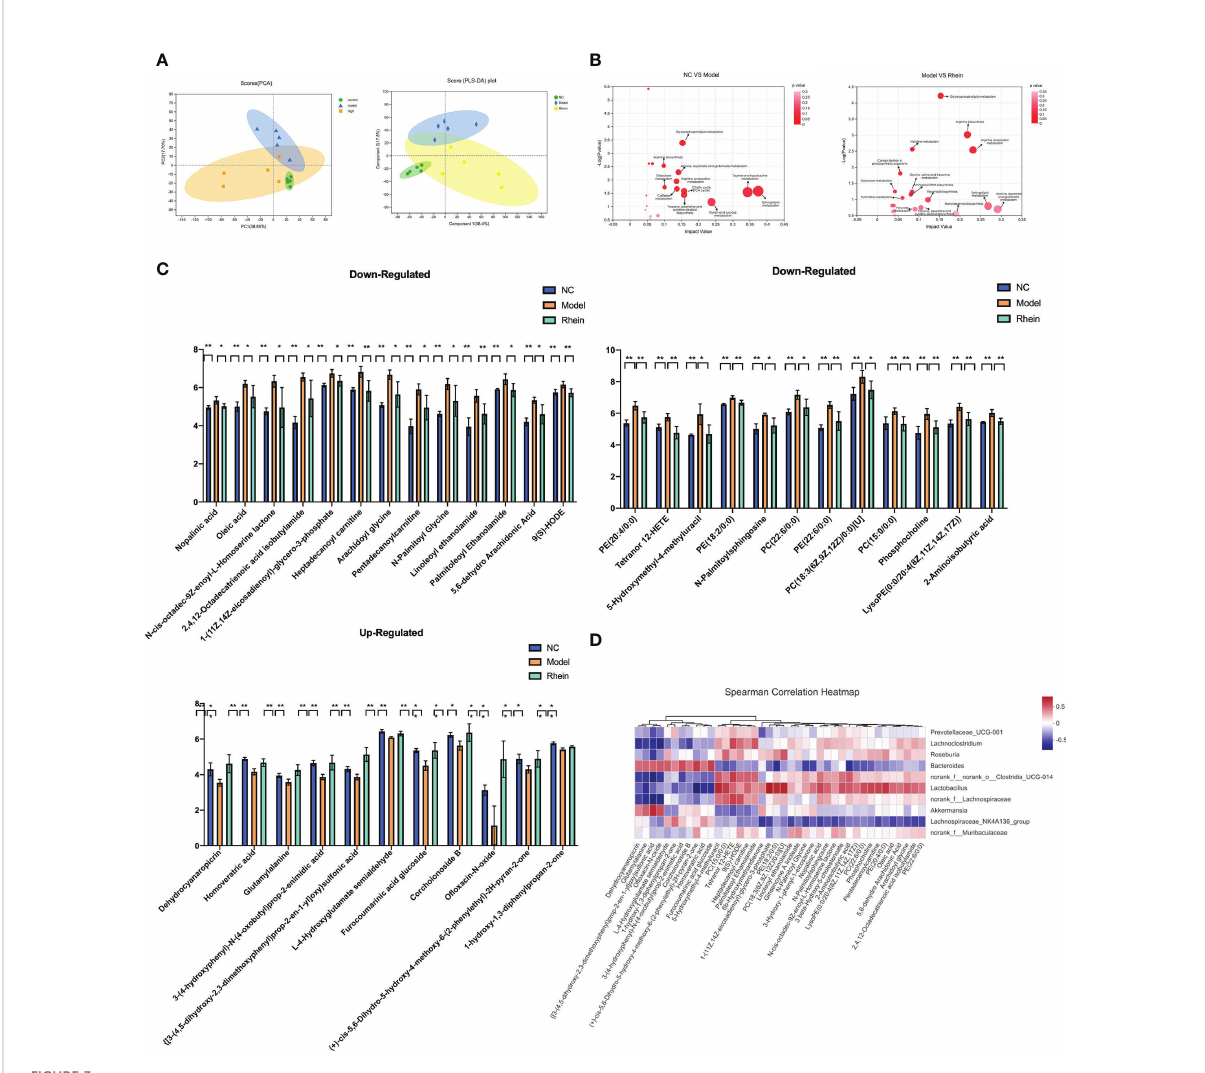
FIGURE 3 Rhein protects against D-galactosamine/LPS-induced altered feceal metabolites. (A) Principal component analysis (PCA) (PC1 = 38.8%): the partial least squared discriminant analysis (PLS-DA) score plot based on LC-MS pro fi ling data of feceal samples (compound1 = 47.2%). Each dot with three kinds of color represents the different samples. (B) Meaningful metabolic pathways in the comparison of NC and Model group, and Model and Rhein groups. (C) Based on VIP > 1, P < 0.05, FDR < 0.05 as a fi lter for differential metabolites between normal control and ALF groups, and rhein treatment signi fi cantly improved metabolic disorders, *p < 0.05 and **p < 0.01. (D) Heatmap of the correlation between the altered microbial community and signi fi cantly changed metabolites. The color indicates the Spearman ’ s correlation coef fi